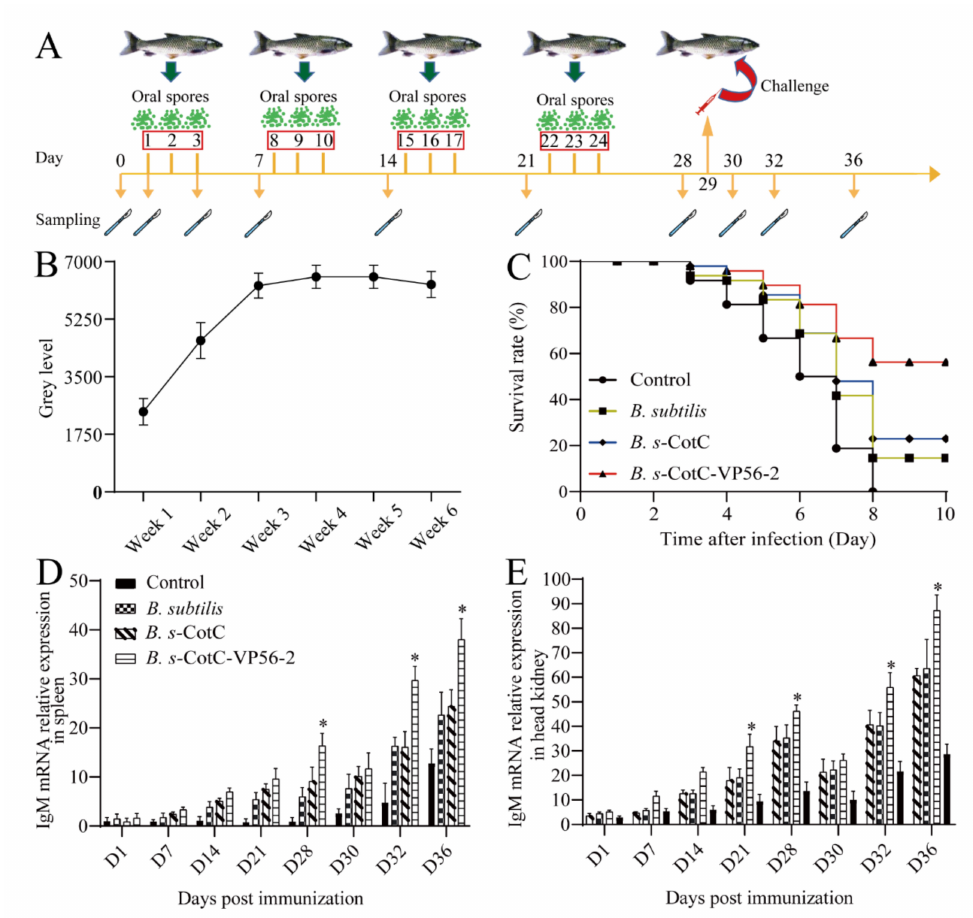
Figure 4. Preparation and in vivo test of oral B. subtilis vaccine. ( A ): Flow chart of vaccination, attack and sampling. ( B ): Image J analysis of spore colonization PCR; ( C ): Cumulative survival rate of grass carp inoculated with GCRV-II. On day 0, each group of fish was fed ordinary feed, B. subtilis feed, B. s -CotC mixed feed and B. s -CotC-VP56-2 feed. Each group of fish (n = 50) was injected with 200 µ L of GCRV virus on the 29th day. Next time, Next, the death of fish in each group was observed. On day 8, all control fish died. ( D , E ): qRT-PCR was used to detect the serum IgM expression level of the grass carp’s spleens and head kidneys, and 18S rRNA was used as an internal control gene. Data are expressed as mean ± SD. Compare the B. s -CotC-VP56-2 group with the control group and other groups. Values that are significantly different from the control are indicated by asterisks (One-way ANOVA, * p < 0.05).